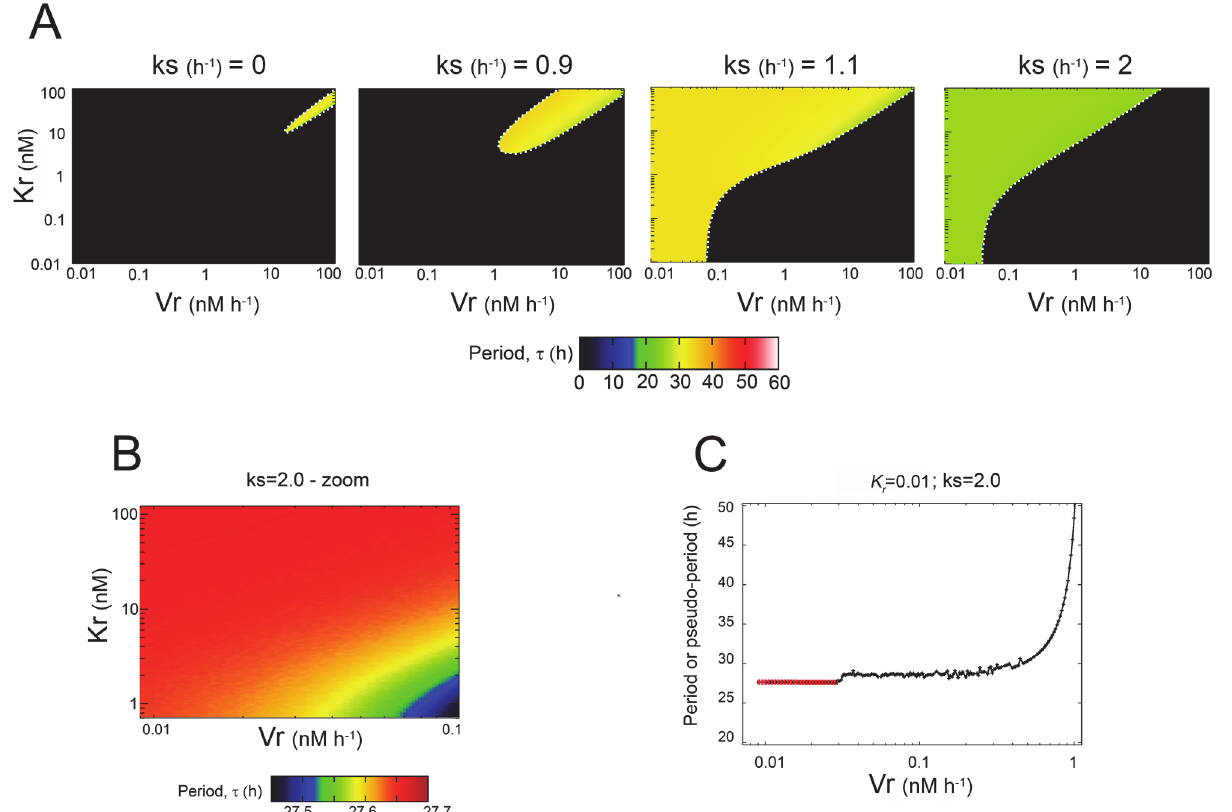
Figure 4. Dependence of the period ( τ ) with k s , K r and V r for nH = 1. ( A ) The τ values are shown in pseudocolor within the K r - V r -subspace for different values of the k s parameter, from 0 ( left ) to 2 h − 1 ( right ). Infradian ( τ (cid:5) 28 h ) are predominant for k s values < 2 h − 1 . For each k s value, the range of τ values is narrower than those observed for nH = 4 (the color key for τ is at the bottom of the plot). Black areas indicate zones in which there are damped oscillations. A white dotted line was added in order to emphasize the transition between the two dynamical behaviors observed in our model. ( B ) An inset of the K r - V r -space shown in panel A for k s = 2 h − 1 ( right ) shows how τ changes within the circadian range; nevertheless the extent of τ change is smaller than that observed for nH = 4. Note that the key color was rescaled in order to display the differences in more detail ( C ) Dependence of τ ( red line ) with V r for a fixed value of K r = 0.01 nM . The black line shows the pseudo-period value for damped oscillations.